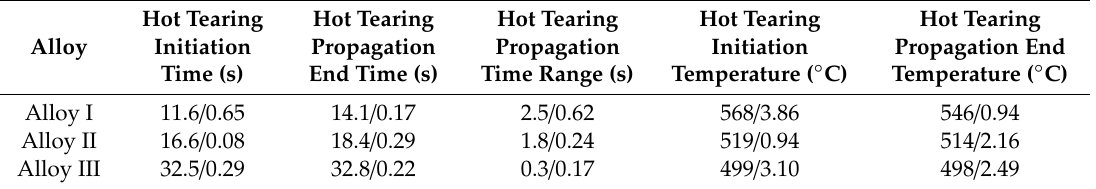
Figure 8. Hot tearing curves of Mg–7Gd–5Y– x Zn–0.5Zr alloys: ( a ) x = 0 wt%; ( b ) x = 3 wt%; ( c ) x = 5 wt%; ( d ) x = 7 wt%. Table 3. Test value/standard deviation of hot tearing parameters of Mg–7Gd–5Y– x Zn–0.5Zr alloys.